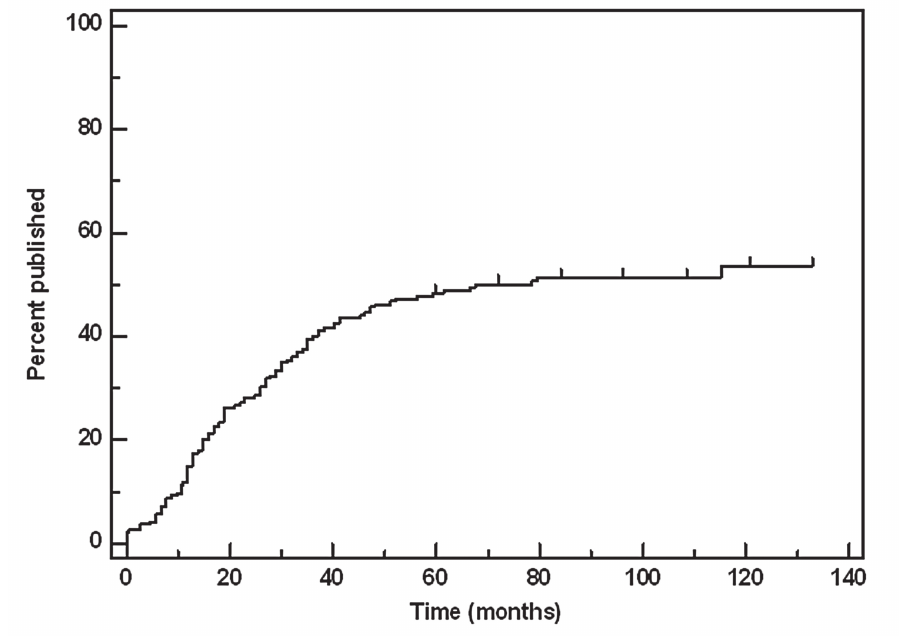
Figure 2 - Time to full publication of Brazilian studies presented at the American Urological Association Annual Meetings between 2001 and 2007 (tick marks represent